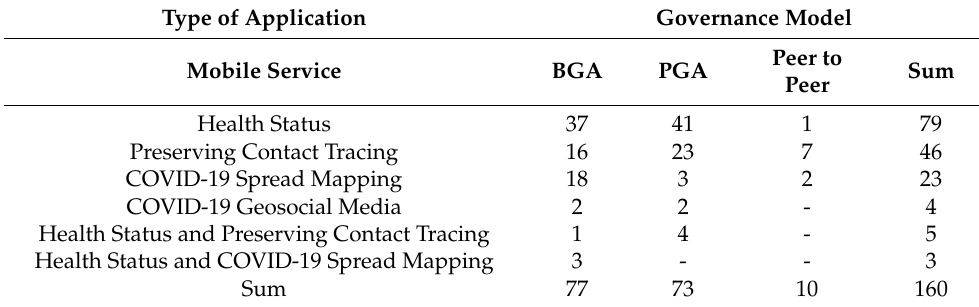
Table 3. Targeting of